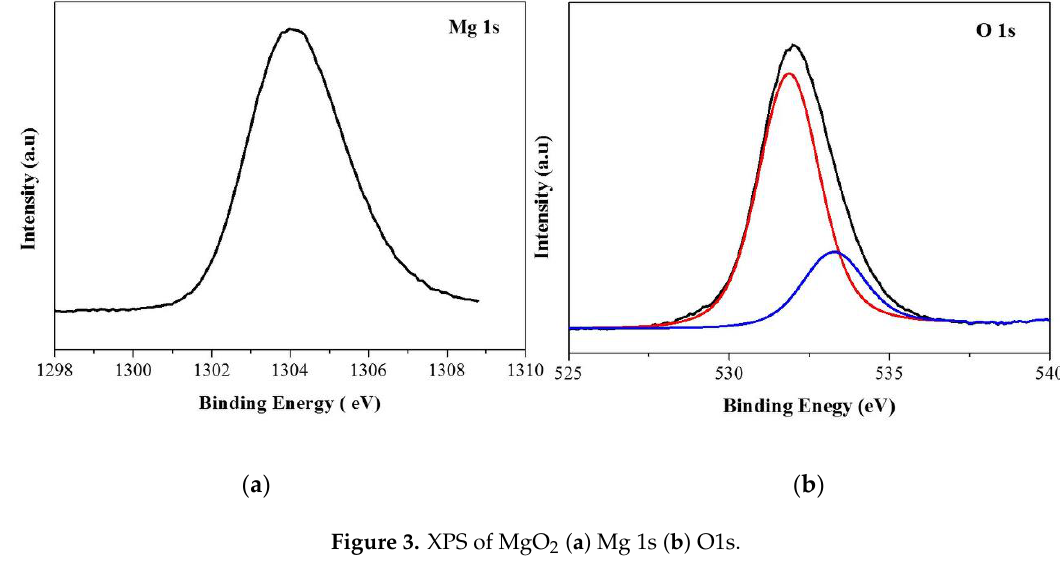
Figure 3. XPS of MgO 2 ( a ) Mg 1s ( b ) O1s.